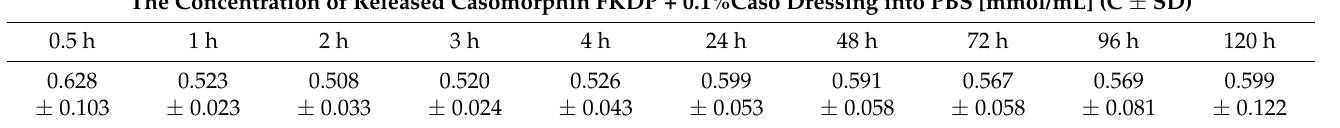
Table 1. Semi-quantitative results of the CE study: detected concentration of casomorphin released from keratin dressing into PBS measured during 120